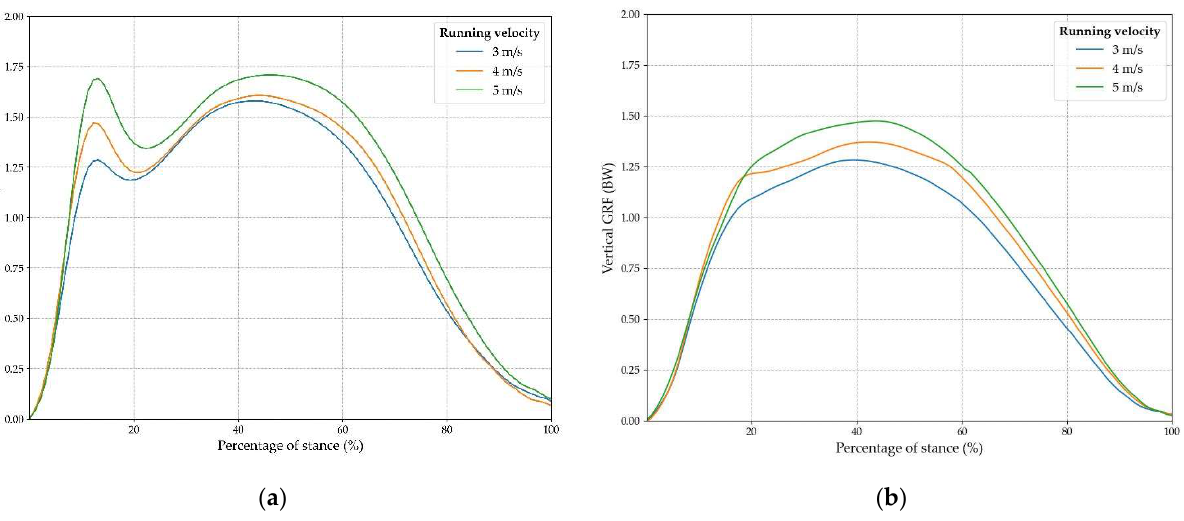
Figure 7. Mean normal GRF curves against percentage of contact time for each velocity condition for rearfoot runners ( a ) and midfoot runners ( b ).